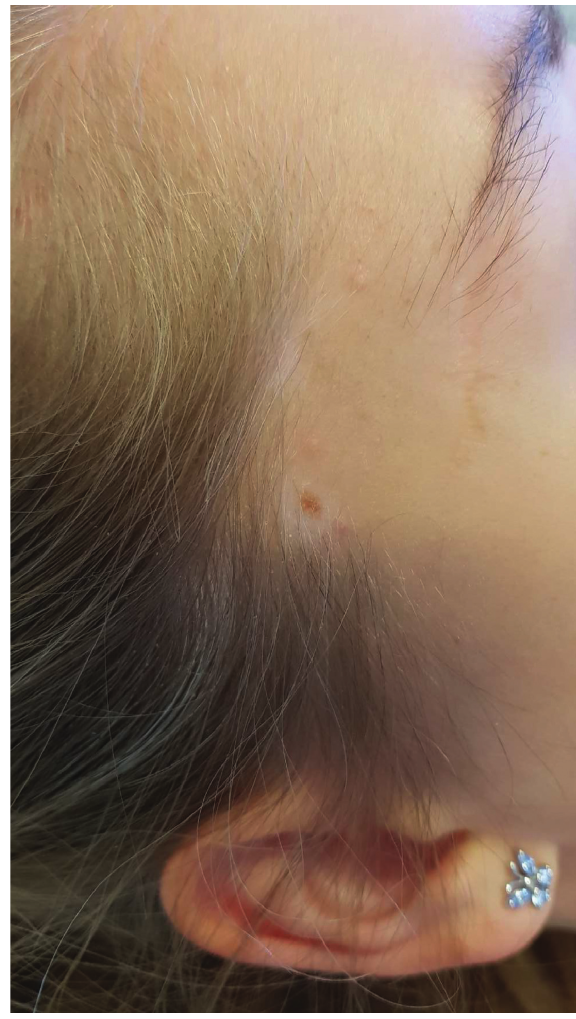
Figure 4: Nevus on the right temporal area surrounded by a symmetrical rim of depigmentation.